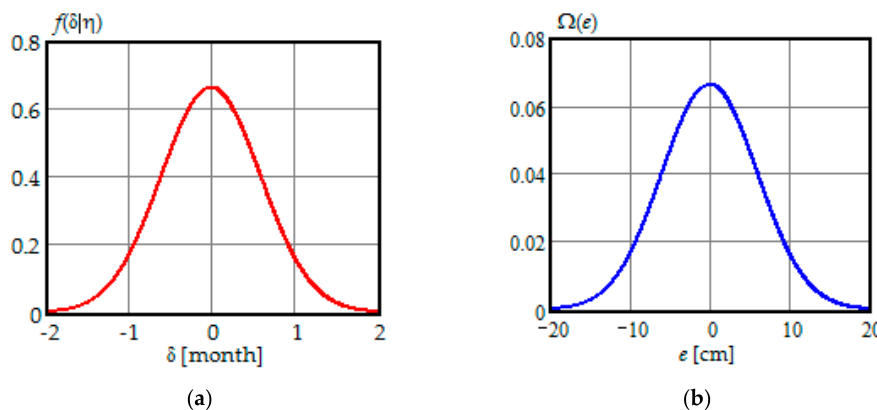
Energies 2019 , 12 , x FOR PEER REVIEW